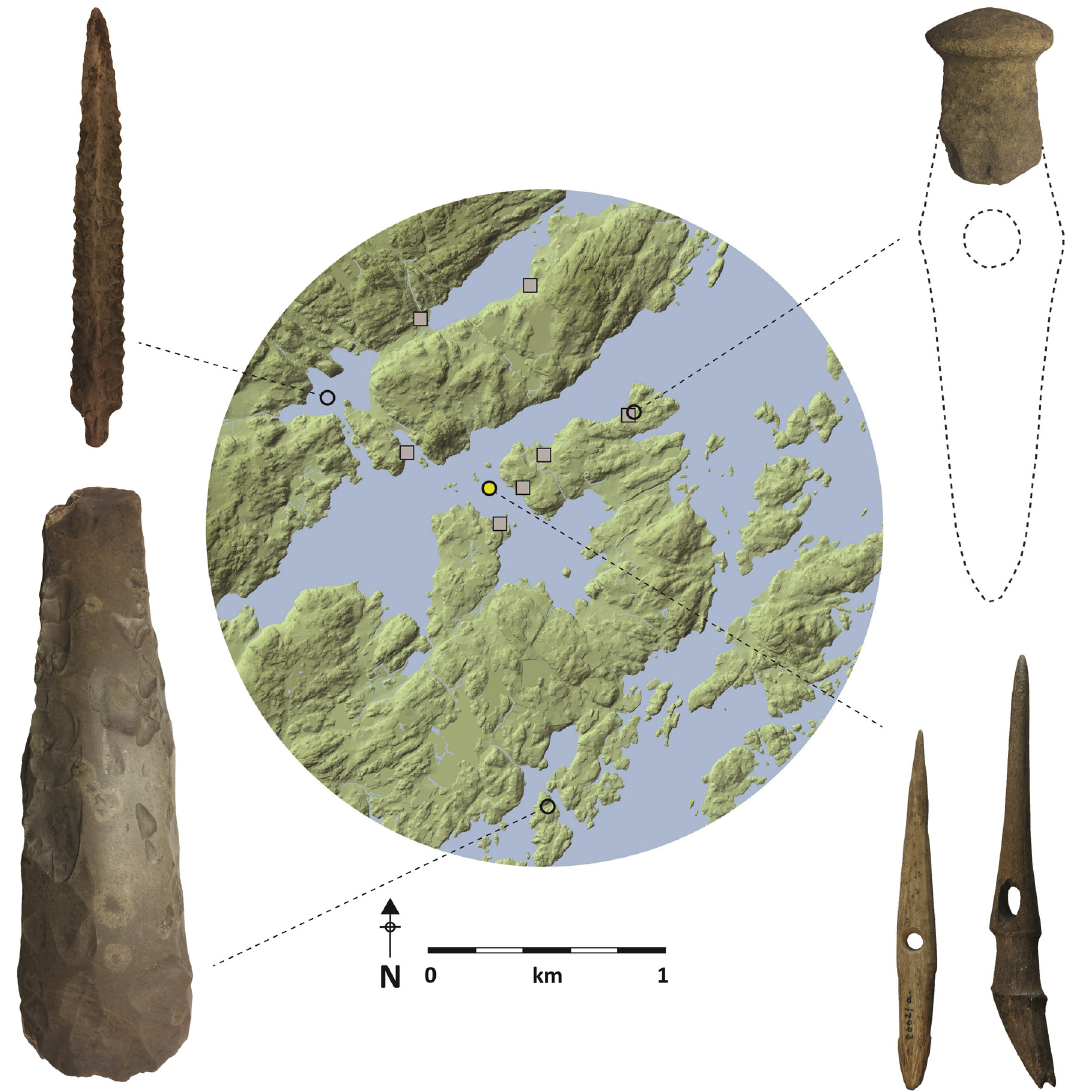
Figure 4: The area around the site Jortveit ( yellow dot ) with sea level elevated 10 m ( c. 3000 – 2500 cal BCE ) , and a selection of Neolithic fi nds in the surrounding area. Circles: Single stray fi nds. Squares: Settlement sites. Top left: Flint arrowhead of type C ( Becker, 1951 ) . Down left: Thick butted and polished fl int axe. Top right: Fragment of polygonal battle - axe of type K III ( Zápotocký, 1992 ) , typical of the Funnel Beaker Culture in Sweden and Norway. Down right: The two toggling harpoons from Jortveit. The harpoon to the right dates directly to 3631 – 3372 cal BCE ( at 95.4%, LuS - 13503, 4715 ± 45 ) . Figure by Svein V.